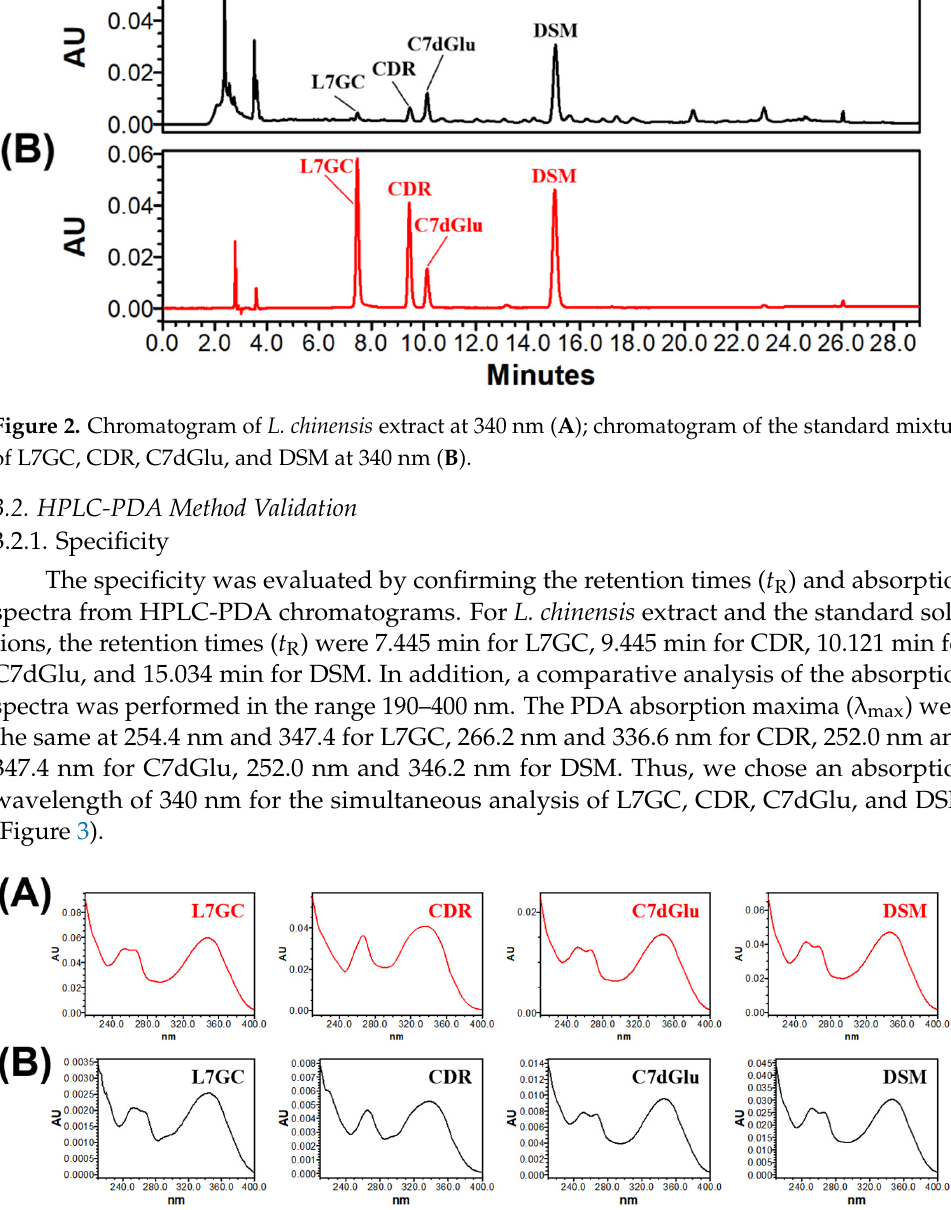
Figure 3. PDA spectra of the standard mixture ( A ) and L. chinensis extract ( B